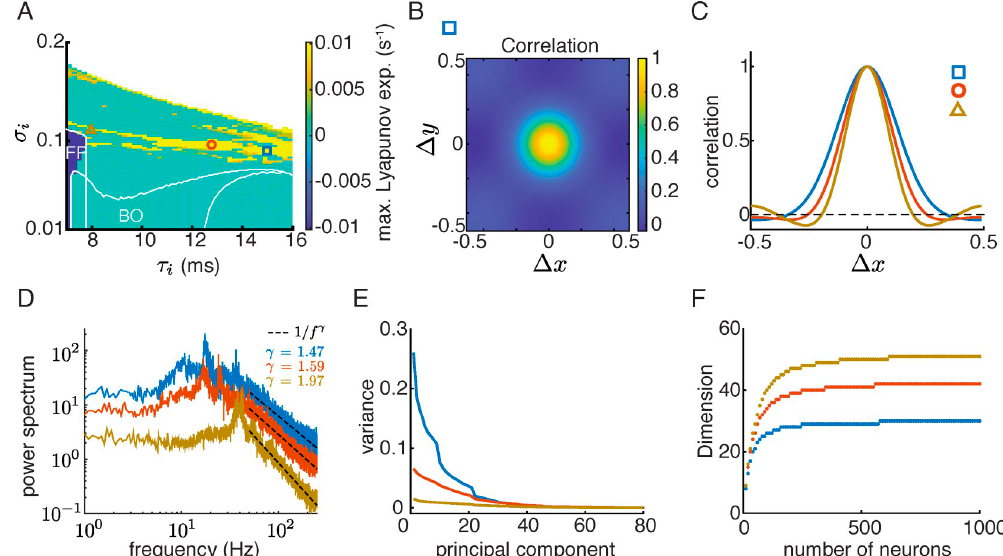
Fig 4. Population statistics of the chaotic solutions. A . The maximal Lyapunov exponent (MLE) as a function of the projection width ( σ ) and the time constant ( τ ) of the inhibitory population for the two-dimensional networks. The white i i curves are the stability borders of the parameter regions of stable fixed point (FP) and bulk oscillation (BO) solutions (same regions as in Fig 2B and S1 Fig). The color axis is limited at ± 0.01 to better visualize the region of positive MLE’s (i.e. chaos region). B . The correlation between neuron activity as a function of distance in x and y directions (Eq 11) in a network labeled as a blue square in panel A. C . The correlation function along the x direction for three networks in the chaotic regime ( Δ y = 0). The network parameters are denoted in panel A with corresponding symbols. D . Population averaged power spectrum of single-neuron rate activity represented in log-log scale (Eq 12). Dashed lines represent 1/ f γ scaling. E . The variance of the dominant principal components of population rate activity of 1000 randomly sampled neurons from the networks, averaged over 100 samples. F . The dimension of population activity saturates as the number of sampled neurons increases. The dimension is defined as the number of dominant principal components that account for 95% of the total variance. Snapshots of network activity from the three networks in C-F are shown in S3